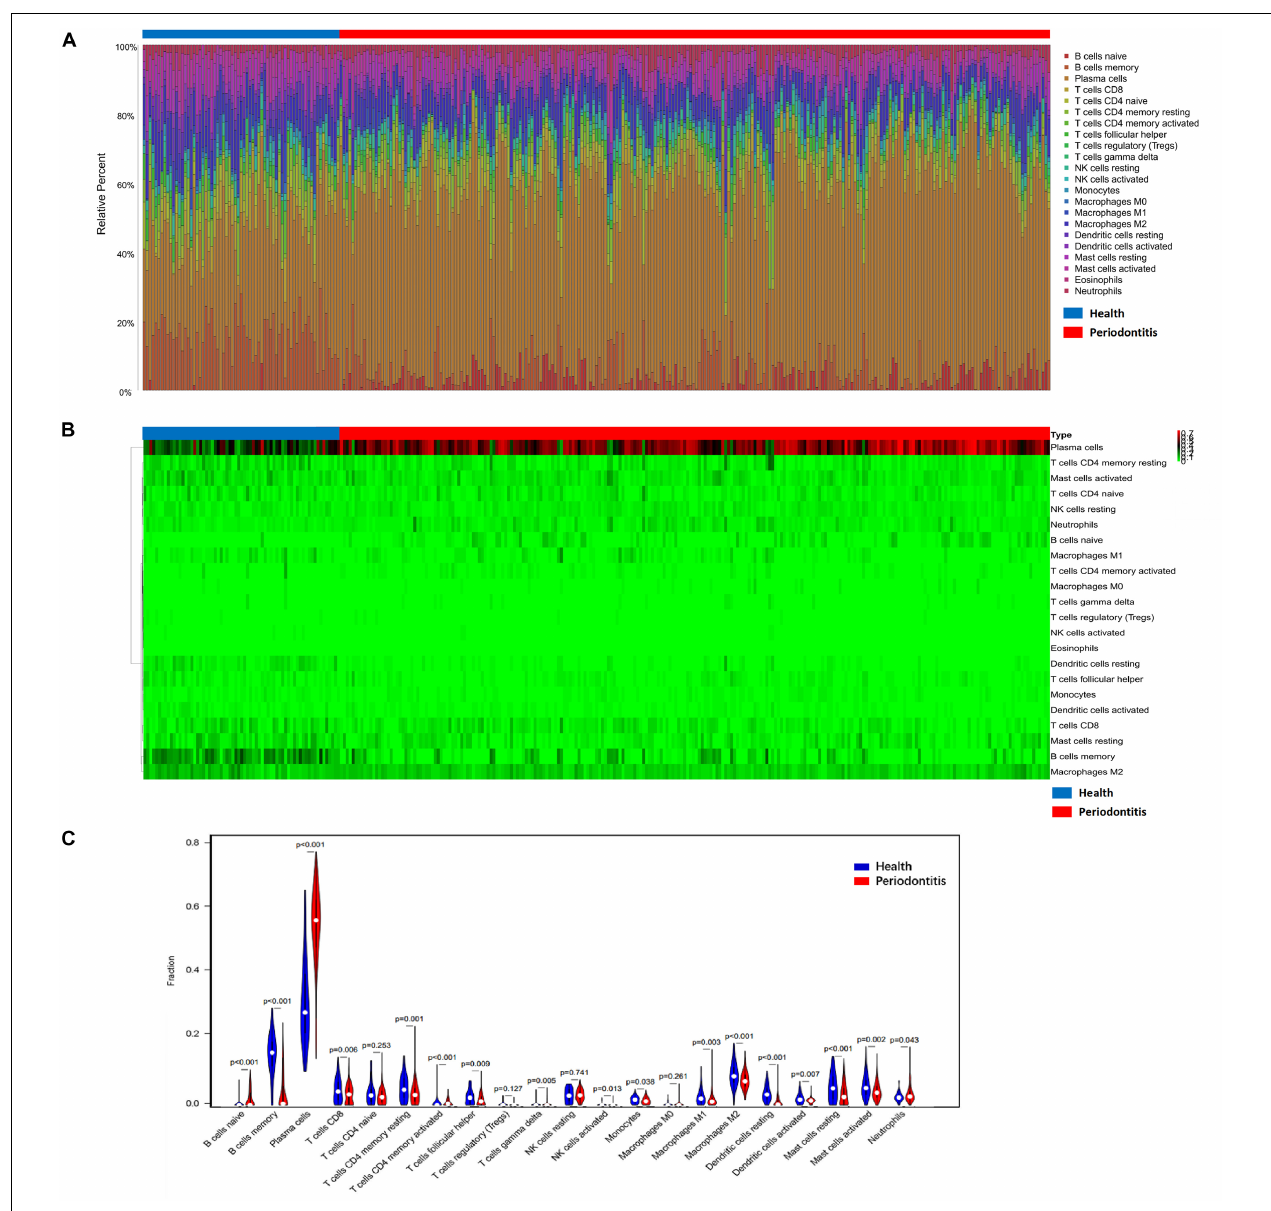
FIGURE 1 | Composition of infiltrated immune cell subpopulations in gingival tissues with or without periodontitis. (A) Fraction of 21 infiltrated immune cell subpopulations determined by CIBERSORT. (B) Heatmap of the gene expression of immune cell subpopulations. (C) Comparison of infiltrated immune cell subpopulations in gingival tissues with or without periodontitis. A high proportion of plasma cells infiltrated in periodontitis individuals. Plasma cells increased in gingival tissues with periodontitis lesion versus those of healthy